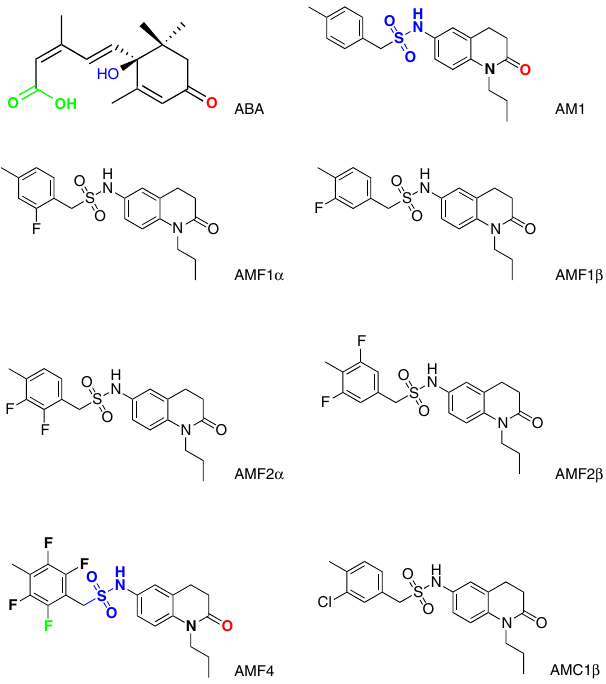
Fig. 1 Two-dimensional chemical structure of AMFs and AMC1 β . As halide derivatives of AM1, AMFs and AMC1 β share a similar AM1 structural motif with one or more halogen atoms ( fl uorine or chloride) added in the 4-menthylphenyl tail. The three hydrogen bond-forming groups of ABA, carbonyl, hydroxyl, and carboxyl, and their counterparts in AM1 and AMF4, are highlighted in red, blue, and green,